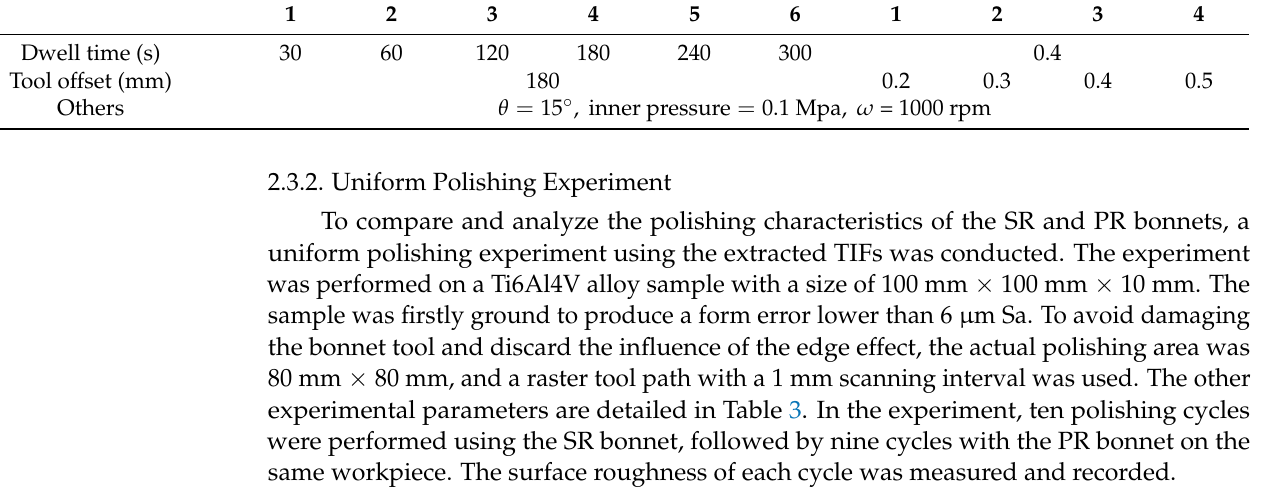
Table 3. Uniform removal conditions.